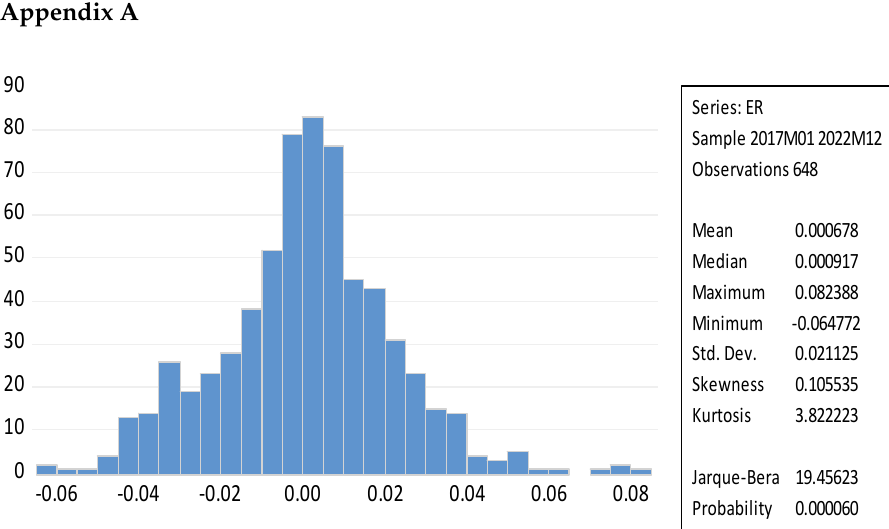
Figure A1. Histogram of the exchange rate change. Descriptive statistics.